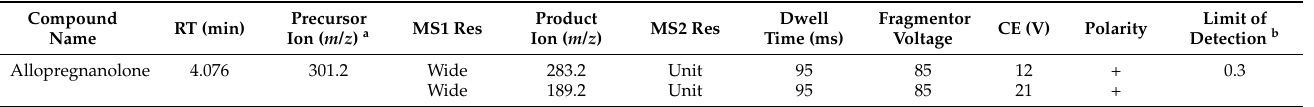
Table A1. Parameters for